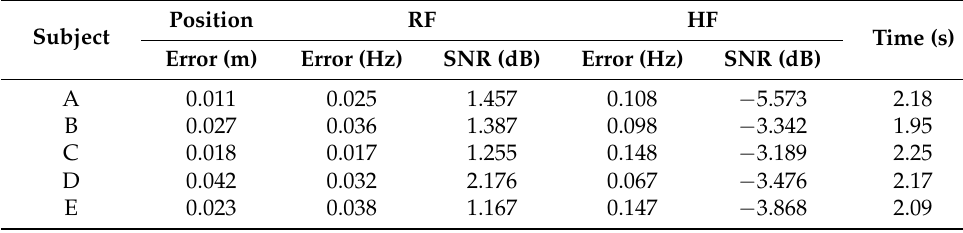
Table 5. Detection results for different subjects.